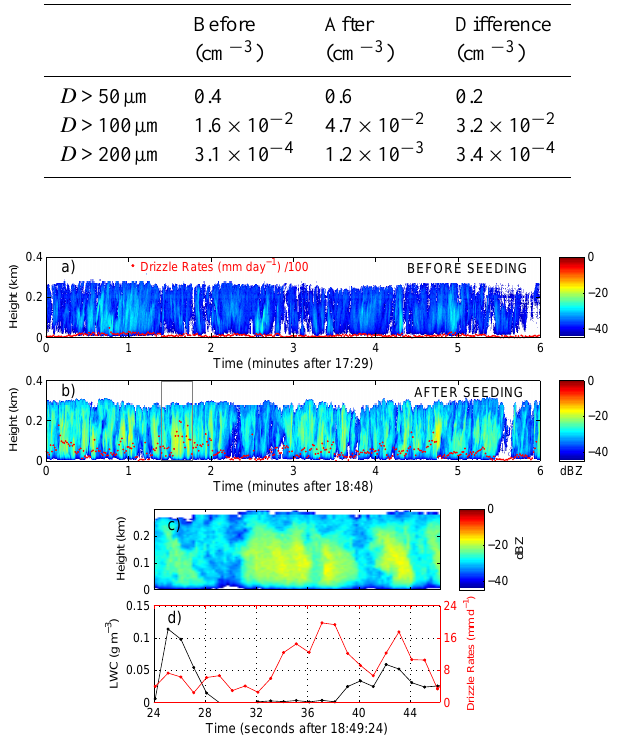
Figure 8. (a) The radar reflectivity (in dBz, reflectivity Z is pro- portional to D 6 of droplet diameters) shows precipitation above the cloud radar in (a) an area of cloud sampled before seeding and the (b) same air mass sampled after seeding during cloud-base level leg. y axes in (a)–(c) indicate the altitudes above the radar during the cloud-base level leg. The drizzle rates in (a) and (b) are esti- mated from the CIP (units of hundredth of mmday − 1 ). The out- lined box in panel (b) indicates where a detailed analysis is made for (c) the radar reflectivity in dBz and (d) drizzle rates (from CIP) in mmday − 1 and the cloud liquid water content (from PVM-100) in gm − 3 .